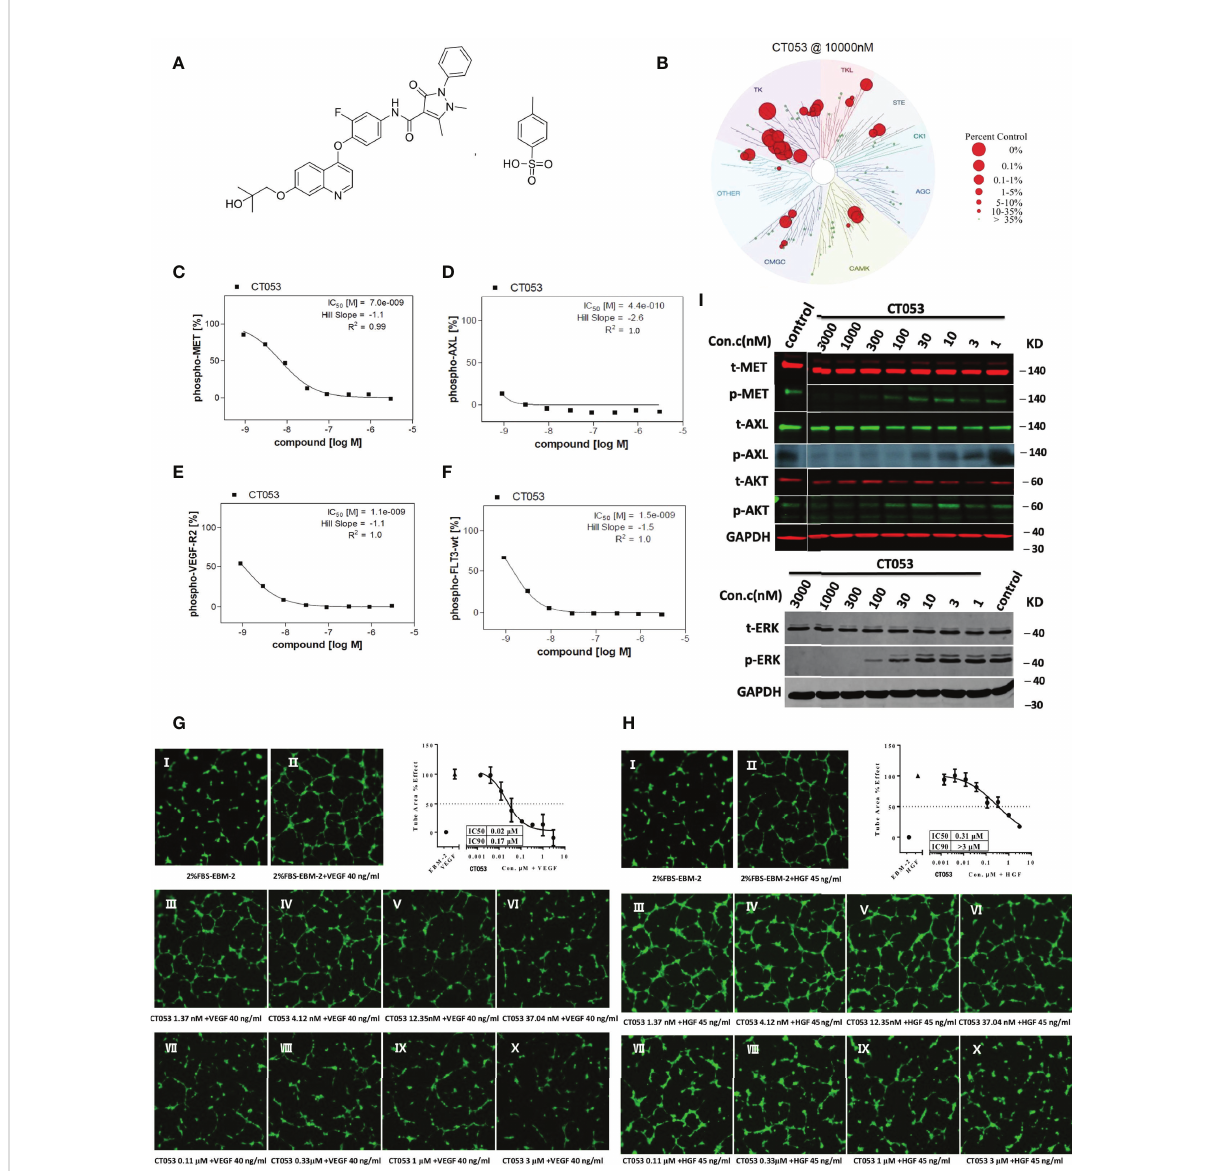
FIGURE 1 Chemical structure, cellular inhibitory effect and tubule formation effect of CT053PTSA in vivo . (A) Chemical structure of CT053PTSA. (B) Small molecule kinase interaction maps for CT053. CT053 was screened against a KinomeScan (http://www.kinomescan.com) panel of 95 kinase assays. Red circles indicate kinases bound, and circle size indicates binding af fi nity. Cellular inhibitory effect of CT053 on kinase phosphorylation: CT053 inhibited the phosphorylation of MET in MKN45 cells, and the IC50 value was 7.0 nM (C) . AXL was examined in AXL- MEFs cells, and the IC50 value was 0.44 nM (D) . VEGFR-2 and FLT3 were examined in HUVECs and FLT-wt-MEFs, and the IC50 values were 1.1 nM (E) and 1.5 nM (F) . CT053 inhibits VEGF-induced (G) and HGF-induced (H) tubule formation. Tubule formation was visualized in HUVECs incubated with 2% FBS-EBM-2 as a control and with VEGF at a concentration of 40 ng/ml and HGF at a concentration of 45 ng/ml. Elevated concentrations of CT053 (1.37 nm (III), 4.12 nm (IV), 12.35 nm (V), 37.04 nm (VI), 0.11 m M (VII), 0.33 m M (VIII), 1 m M (IX), and 3 m M (X)) were coincubated with VEGF/HGF, the percentage area of tube formation stimulated by VEGF/HGF decreased, and the IC50 values were 0.02 m M and 0.31 m M. (I) Inhibition of the phosphorylation of MET, AXL and signaling molecules (AKT and ERK) in SNU-5 cells. SNU-5 cells were treated with different dilutions of CT053 (3000 nm, 1000 nm, 300 nm, 100 nm, 30 nm, 10 nm, 3 nm, and 1 nm), and MET autophosphorylation, AXL phosphorylation, AKT phosphorylation, and ERK phosphorylation were all inhibited by CT053. AXL phosphorylation was completely suppressed by 100 nM CT053, and the phosphorylation of MET and its downstream protein ERK was inhibited by 1000 nM CT053. A higher concentration of CT053 was required to suppress the induced activity of